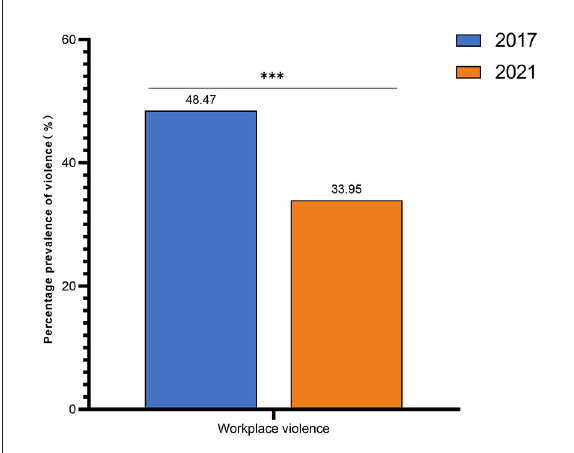
FIGURE1 Statistical chart of the change in the total prevalence of violence. Both 2017 and 2021 in the figure refer to the year. The prevalence of WPV in hospitals decreased from 48.47 in 2017 to 33.95% in 2021. *** indicates that P < 0.001. Total workplace violence prevalence, Pearson’s Chi square = 40.974, P < 0.001.